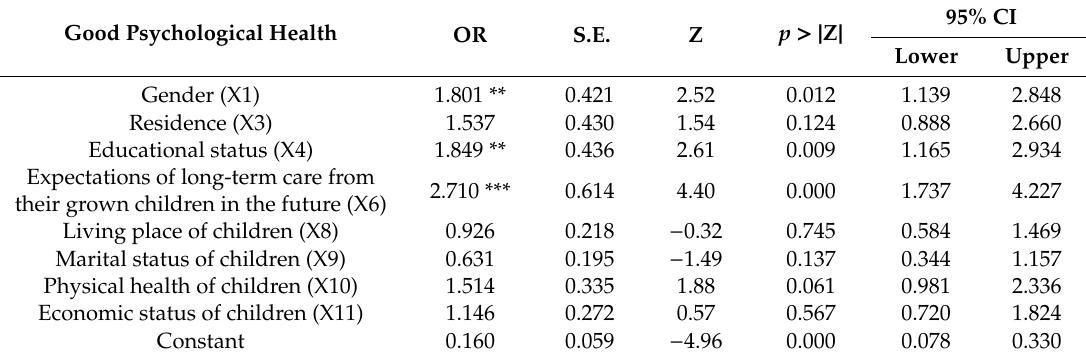
Table A2. Logistic regression results in the fourth step (full details).